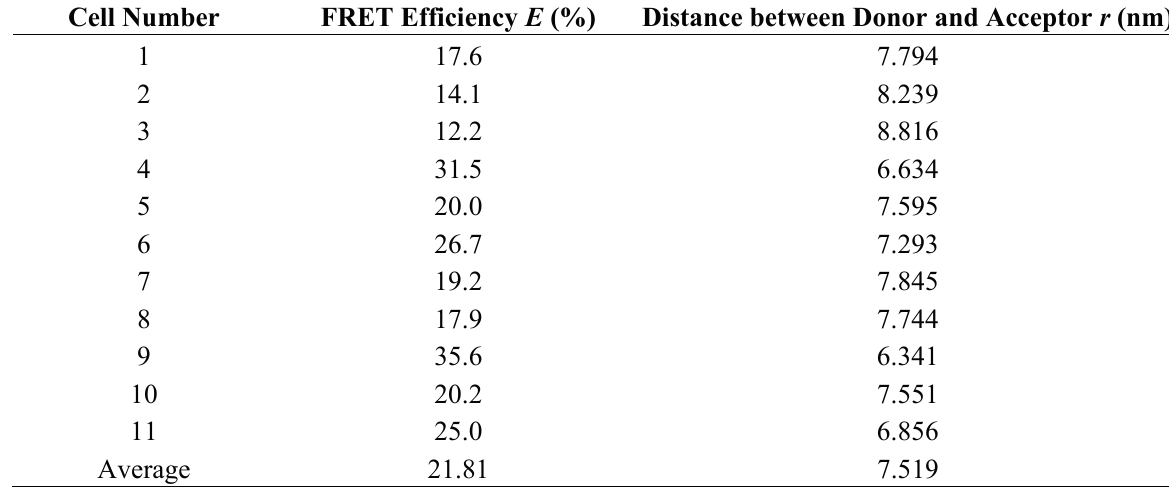
Table 2. FRET efficiency and distance of the ROI from the cells co-transfected with pECFP-C1- SelP' and pEYFP-C1- Tub determined by receptor photobleaching